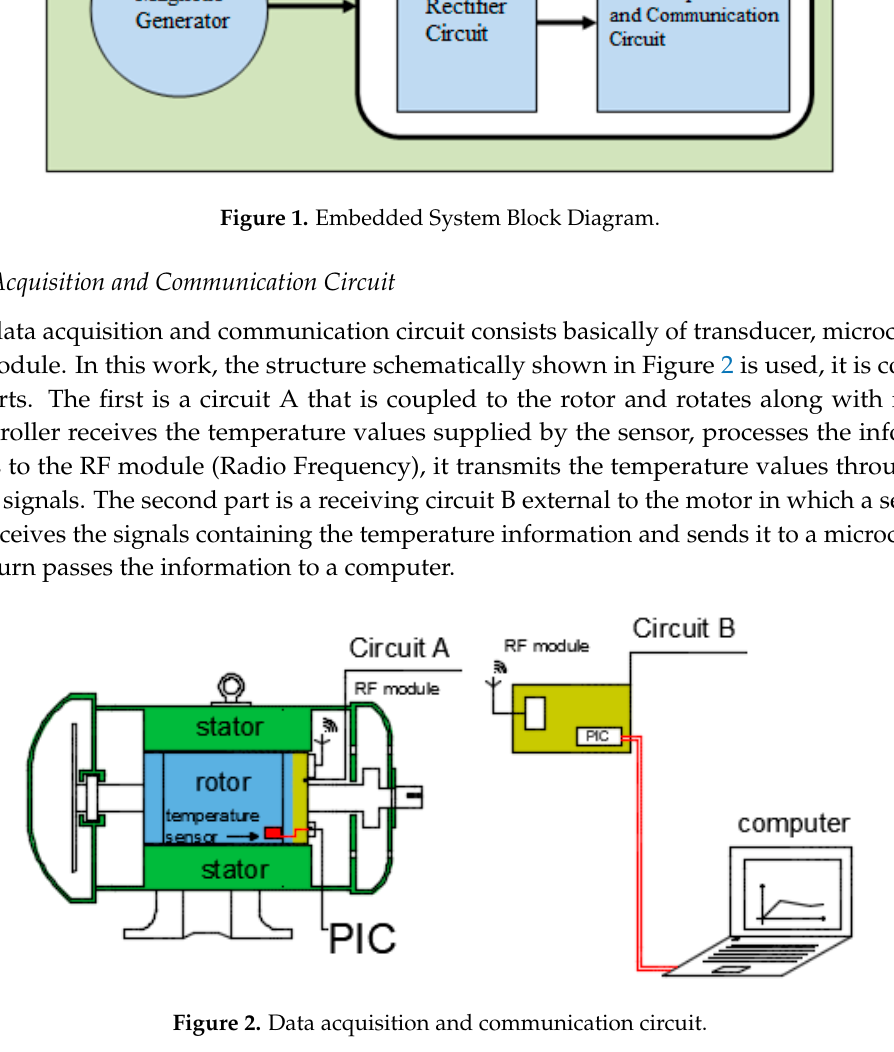
Figure 2. Data acquisition and communication circuit.